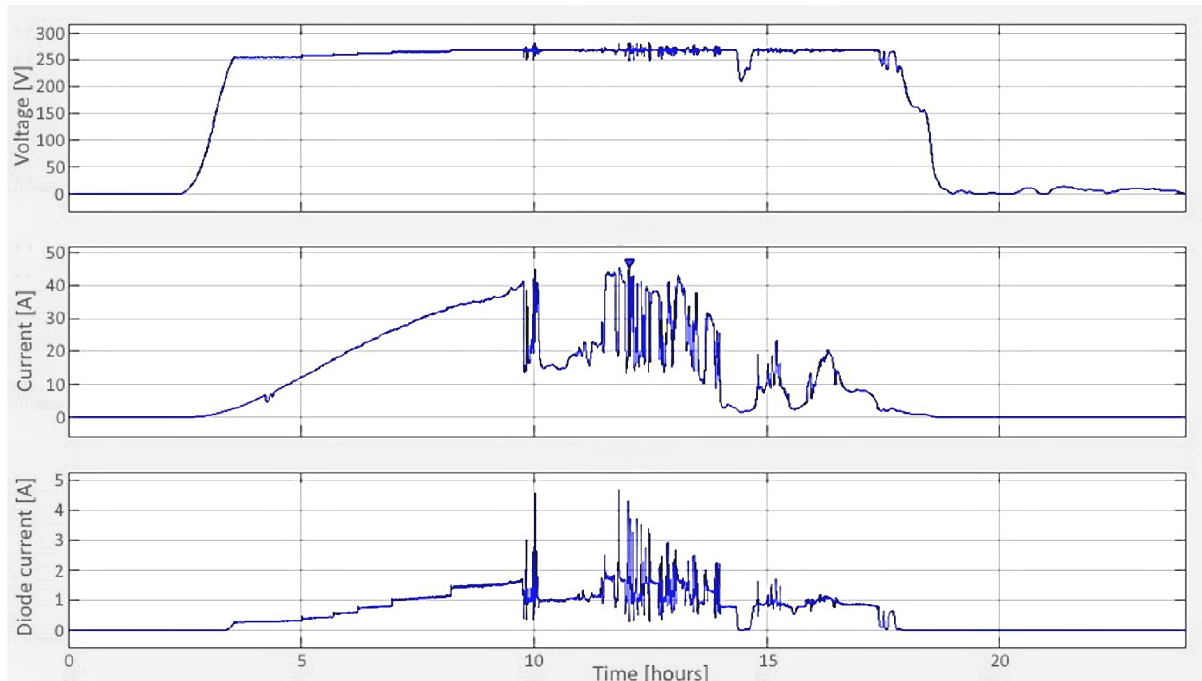
Figure 20. Daily waveforms of voltage and current of the PV modules (12.2 kW) and PV diode current on a sample day in July. Table 2. Values of voltage and current on PV modules (12.2 kW) and PV diode current on a sample day in July.